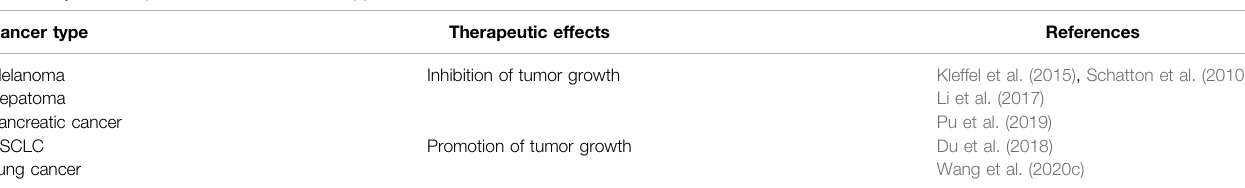
TABLE 4 | The therapeutic effects of PD-1 therapy in tumor